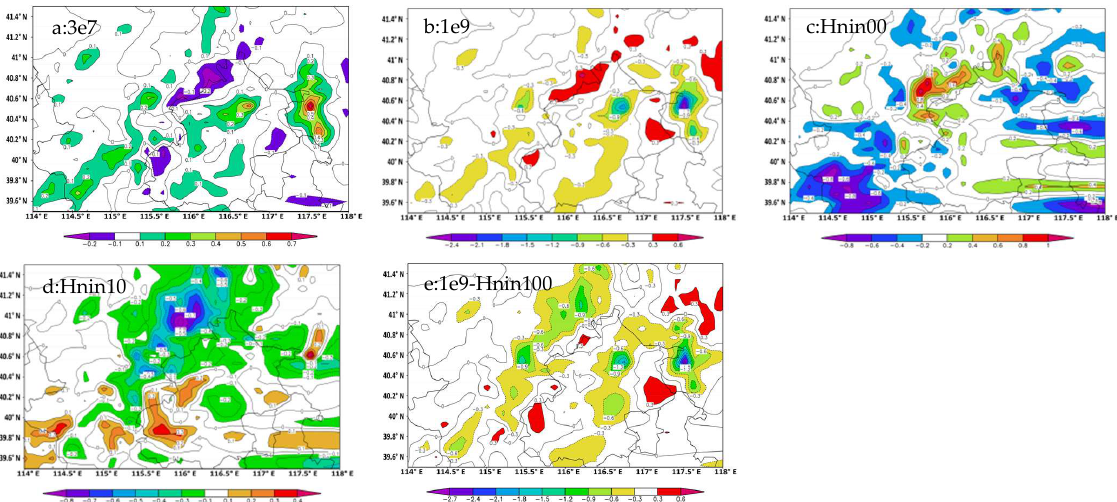
Figure 3. The distribution of the daily snowfall deviation (mm) of five sensitivity experiments and control simulations (Psen-PCtrl); ( a – e ) the 3e7, 1e9, Hnin001, Hnin100, and 1e9-Hnin100 tests,